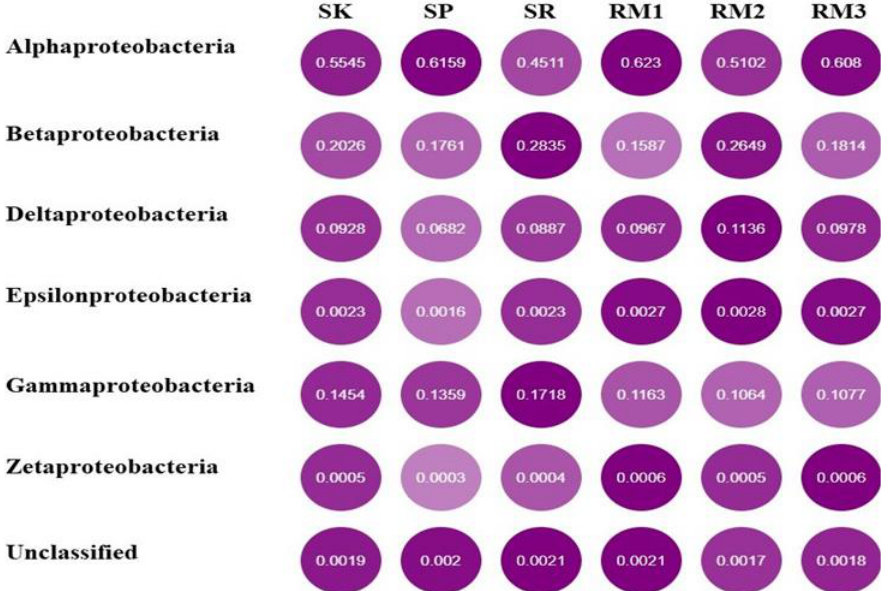
Figure 3. Proteobacteria class compositions (abundance matric) of the Royal Belum (SK, SP, and SR) and Raja Muda Musa (RM1, RM2, and RM3) metagenomes as determined by the WGS Shotgun. Taxonomic assignments were performed using MgRast.